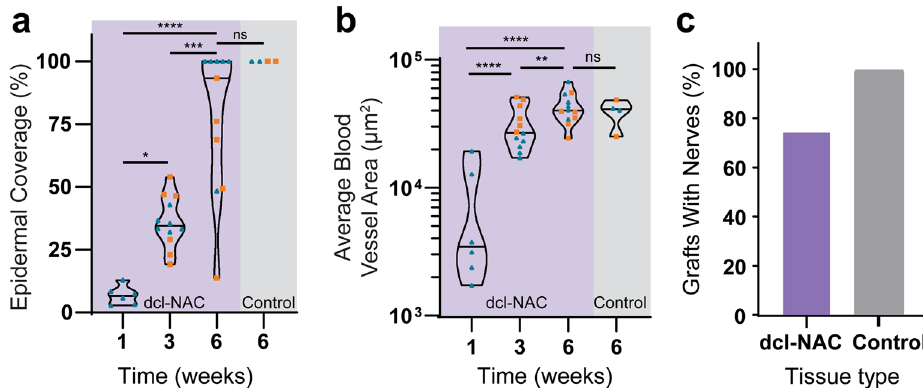
Figure 5. Quantitative analysis of dcl-NAC re-cellularization at study endpoints. ( a ) Percent epidermal coverage of the exposed surface of dcl-NACs and intact, non-decellularized, native NHP controls. ( b ) Average blood vessel area in dcl-NACs and intact, non-decellularized, native NHP controls. Blue triangles, NHP1; orange squares, NHP2. P ≤ 0.05, *; P ≤ 0.01, **; P ≤ 0.001, ***; P ≤ 0.0001, ****; ns, not significant. ( c ) Percent of grafts in which nerves were identified at week